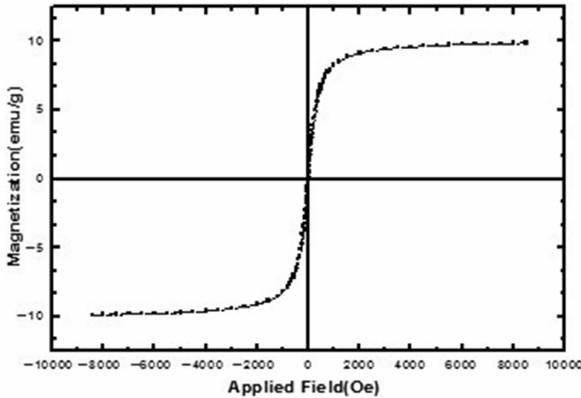
Figure 6: Magnetization versus applied field for FeAl 2 O 4 nanoparticles at